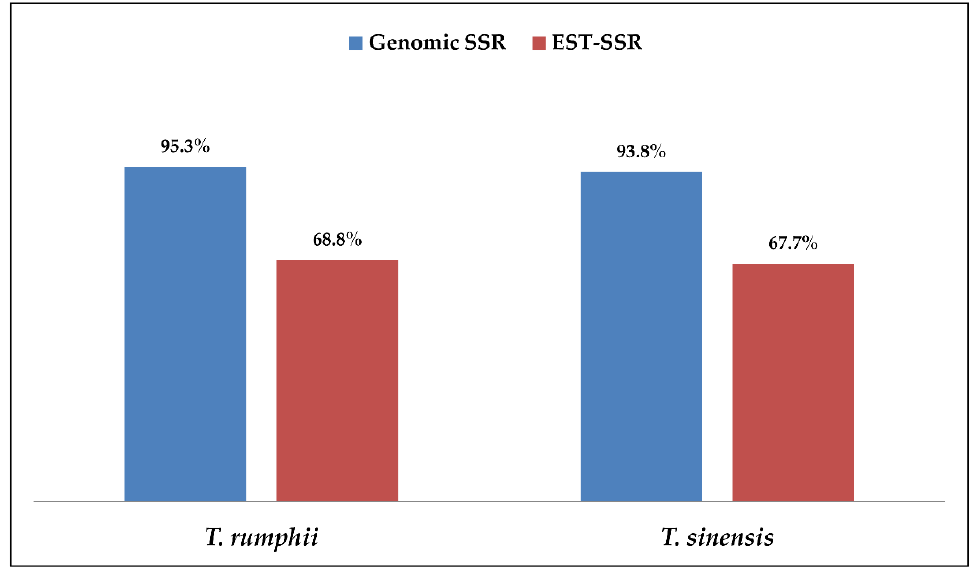
Figure 6. Comparison of cross-species transferability rate in Tinospora rumphii and Tinospora sinensis by using g-SSR and EST-SSR markers .